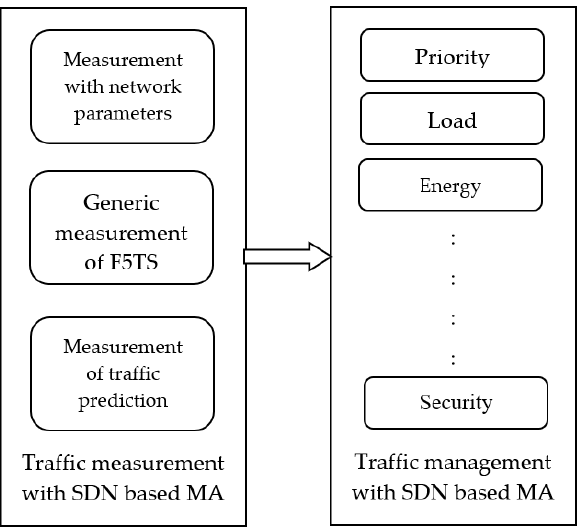
Figure 5. Managing vehicular data traffic within 5G environments.